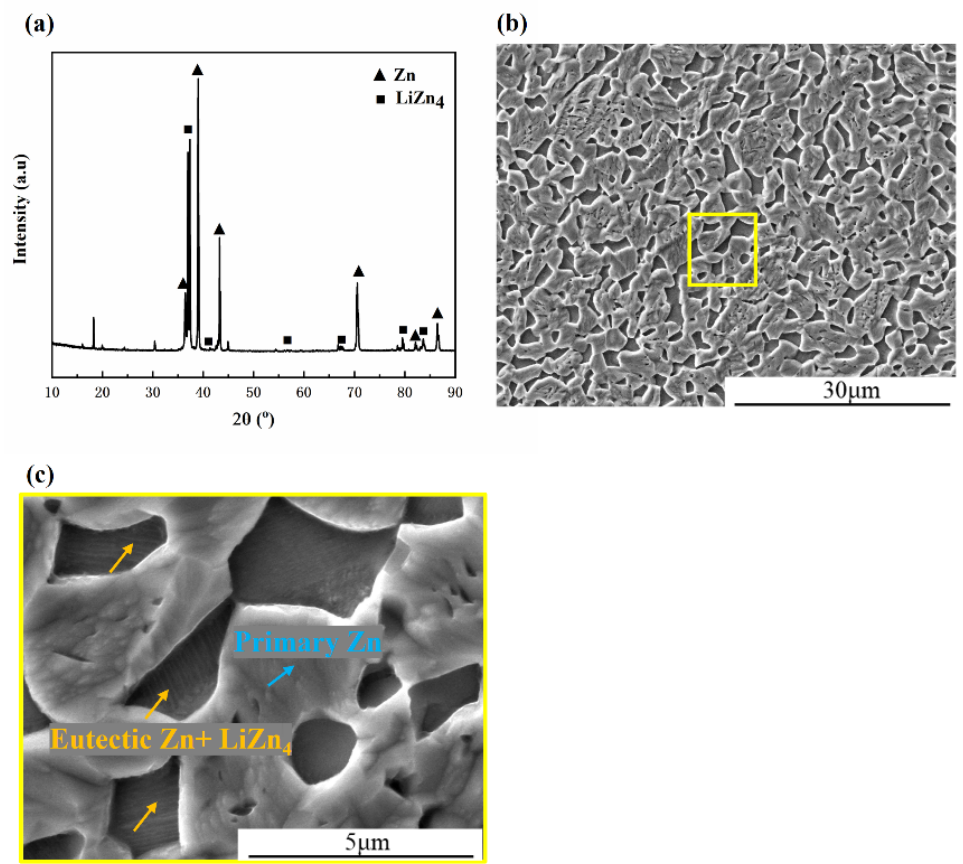
Figure 1. Microstructure characterization of Zn–0.4Li before immersion in solutions. ( a ) XRD spectra and ( b ) SEM image. ( c ) High-magnification image of the yellow frame.